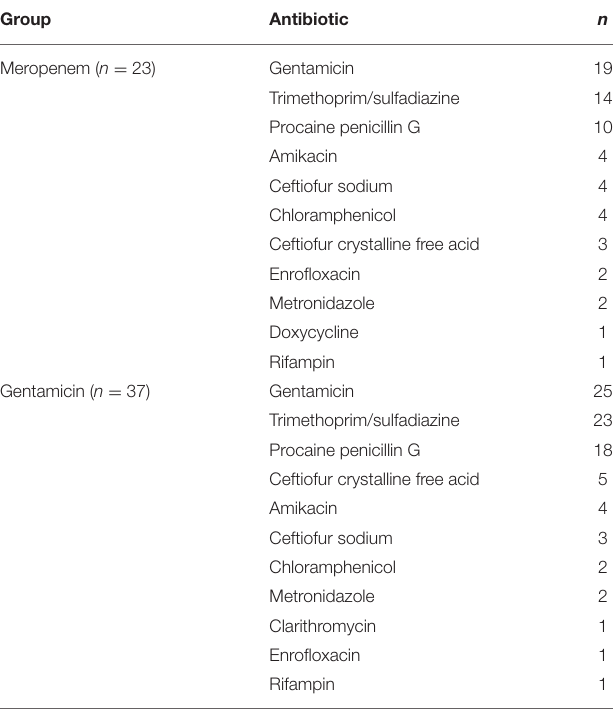
TABLE 6 | Concurrently administered antimicrobials for horses administered either meropenem or gentamicin via intravenous regional limb perfusion (IVRLP). Group